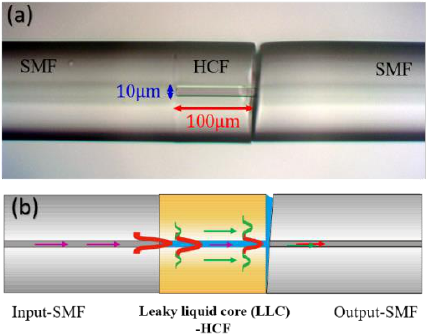
Figure 1. ( a ) Microphotograph of the LLCFMZI sensor. The LLC-HCF with D = 10 μm and L~100 μm. ( b ) Schematic of the interference between the leaky-core and cladding modes in the